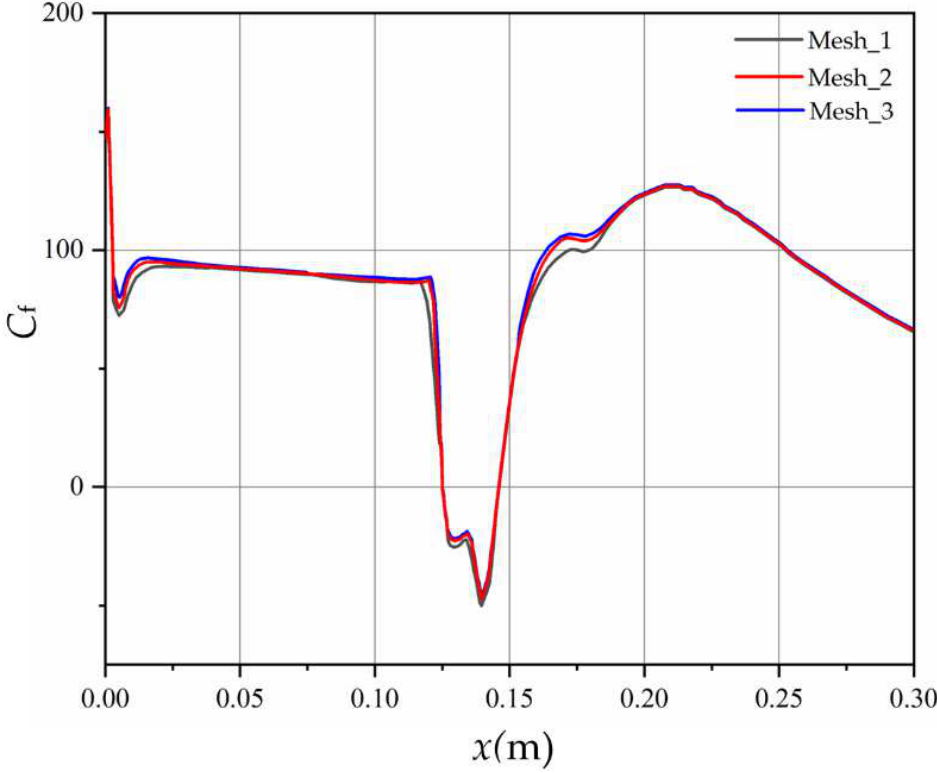
Figure 6. The height of the first layer of the skin was set to 0.007 mm to ensure y + < 1.